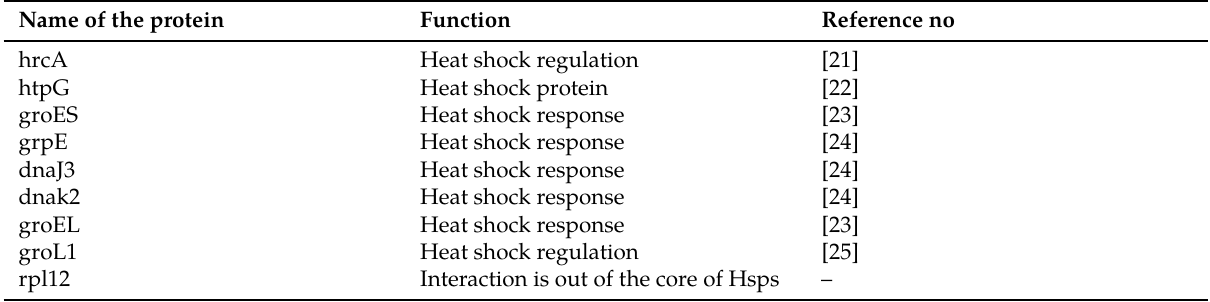
Table 2: Table showing the functions of the protein which are in interaction with the query protein hypothetical protein P9303_05031. Most of the proteins which are in interaction with the query protein were annotated as the proteins which involve in heat shock response and